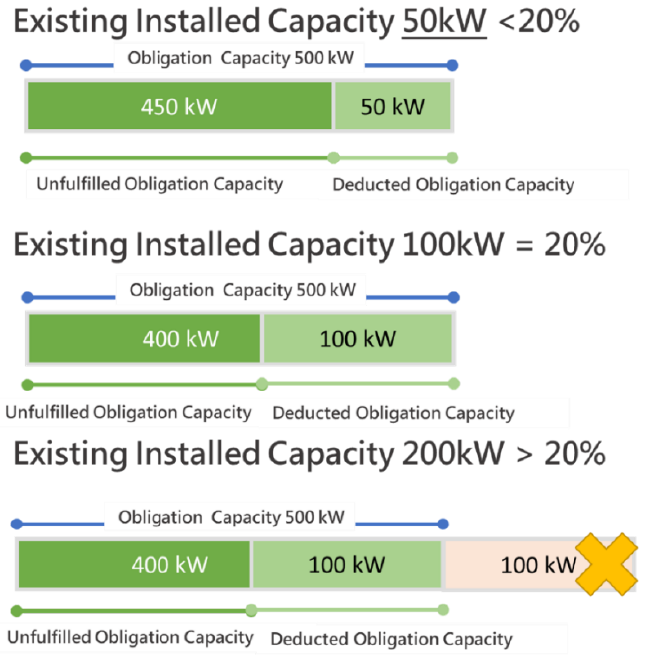
Figure 10. Deduction program for existing installed capacity . Source: This study.